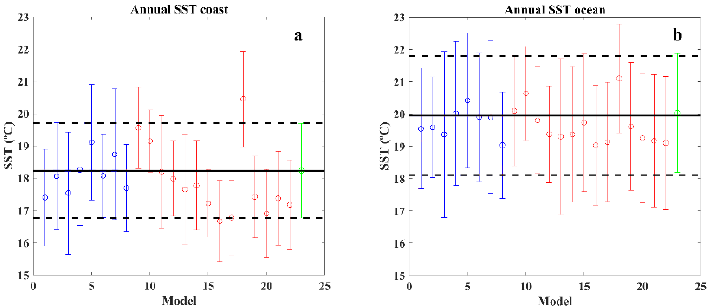
Figure 5. Canary upwelling system mean SST value (±1 SD) for the OISST ¼ (black solid line) and each CMIP6 model for: ( a ) coastal and ( b ) oceanic points. The number and color of each model refer to Table 1.